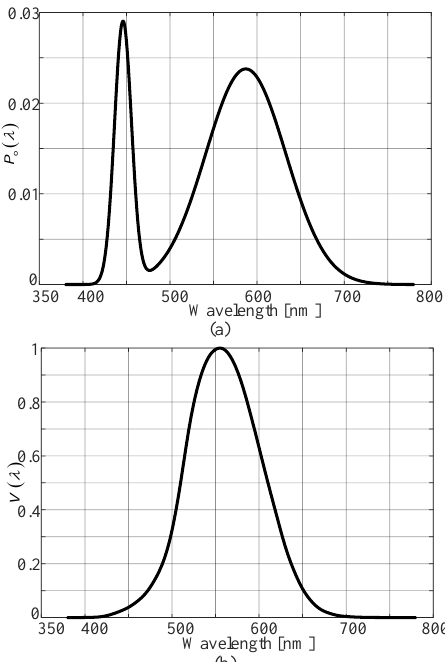
Figure A1. ( a ) The normalized optical spectrum of a typical white LED; ( b ) The normalized Photopic